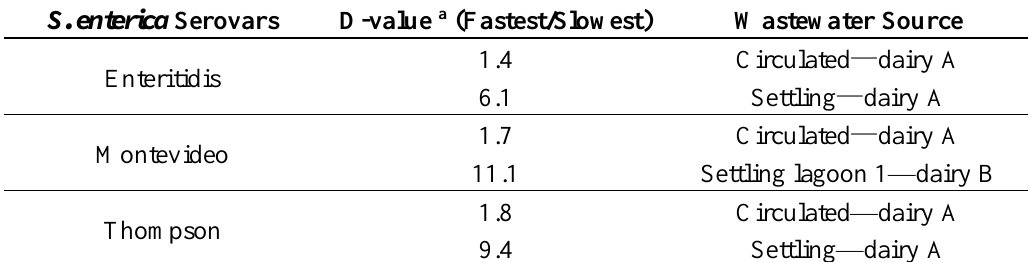
Table 3. Range of D-values obtained for Salmonella strains from microcosm tests using wastewaters from two